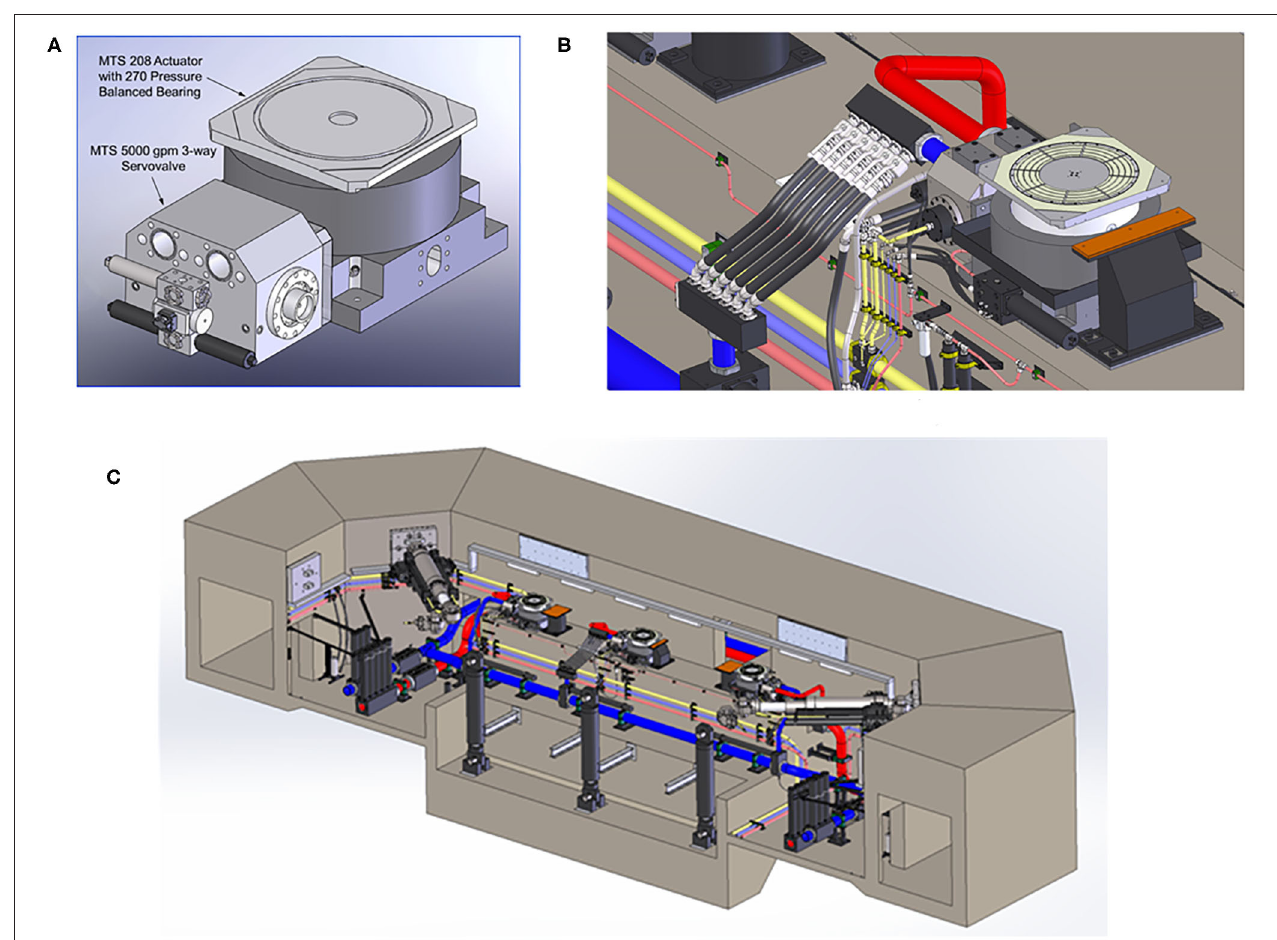
FIGURE 6 | High-flow servovalves for vertical actuators: (A) servovalve-actuator pair, (B) connection of servovalve to pressure (red) and return (blue) pipes, and (C) longitudinal cut through the reaction mass longitudinal axis.